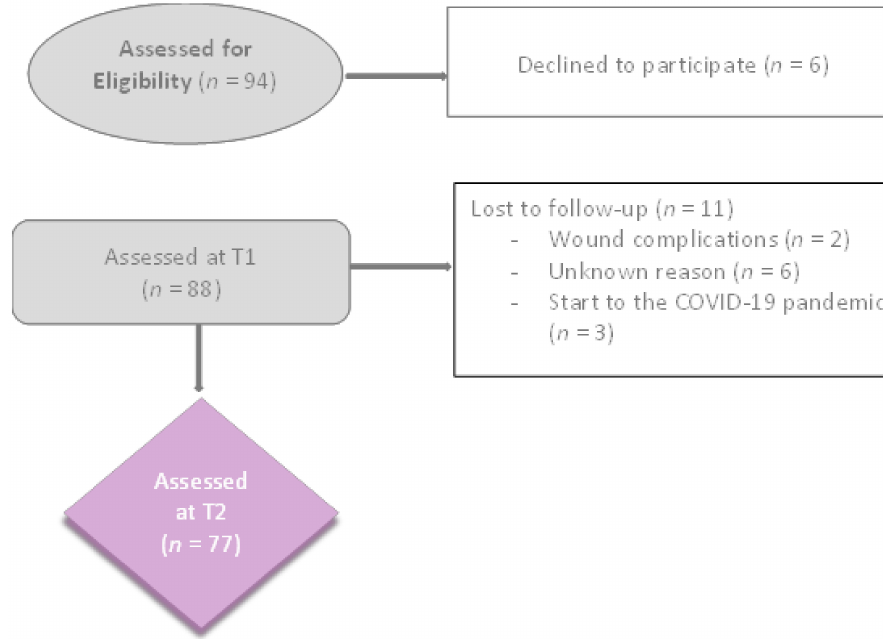
Figure 1. Flow chart of the